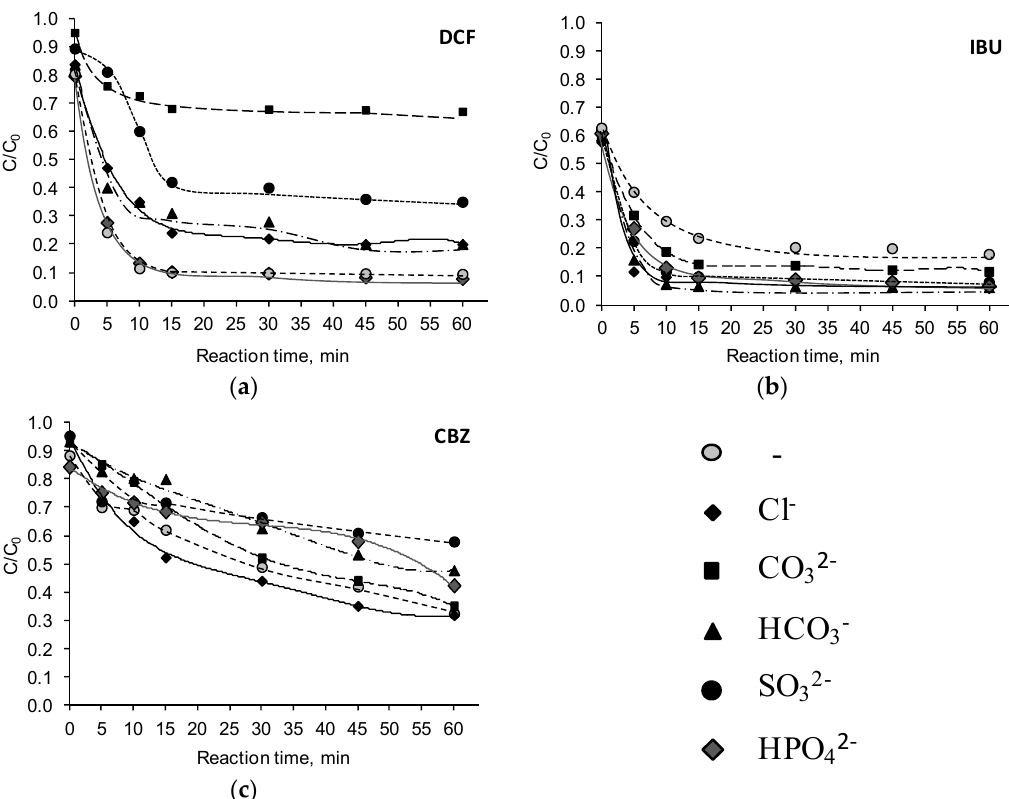
Figure 2. Influence of selected anions on the photocatalytic degradation of pharmaceuticals ( a ) diclofenac sodium salt (DCF); ( b ) ibuprofen sodium salt (IBU) and ( c ) carbamazepine (CBZ) present in water suspensions.